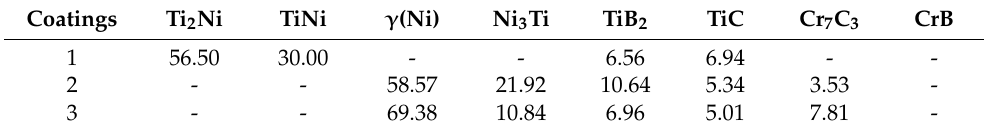
Table 3. The area fraction of different phases in the coatings